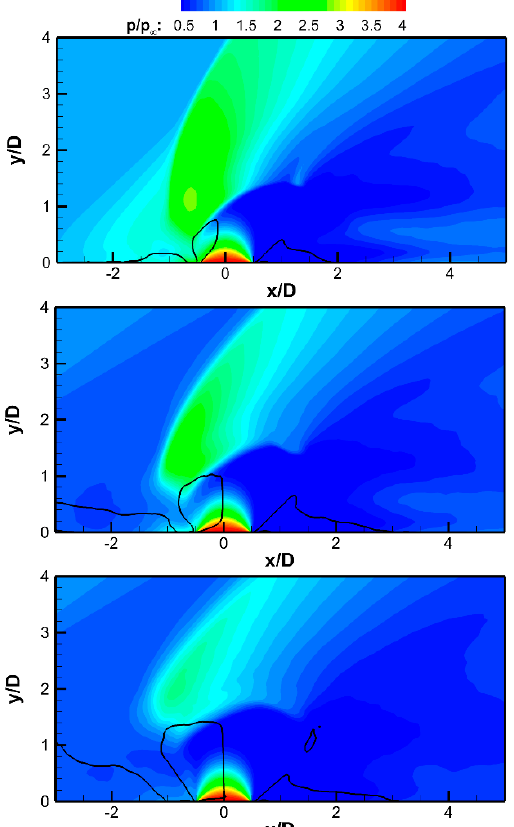
Figure 7. Pressure 𝑝/𝑝 (cid:2998) contours with the isoline ( 𝑢/𝑢 (cid:2998) = 1 × 10 (cid:2879)(cid:2873) ) in the centerplane for cases 1, Figure 7. Pressure p / p ∞ contours with the isoline ( u / u ∞ = 1 × 10 − 5 ) in the centerplane for cases 1, 2, 2, and 3. and